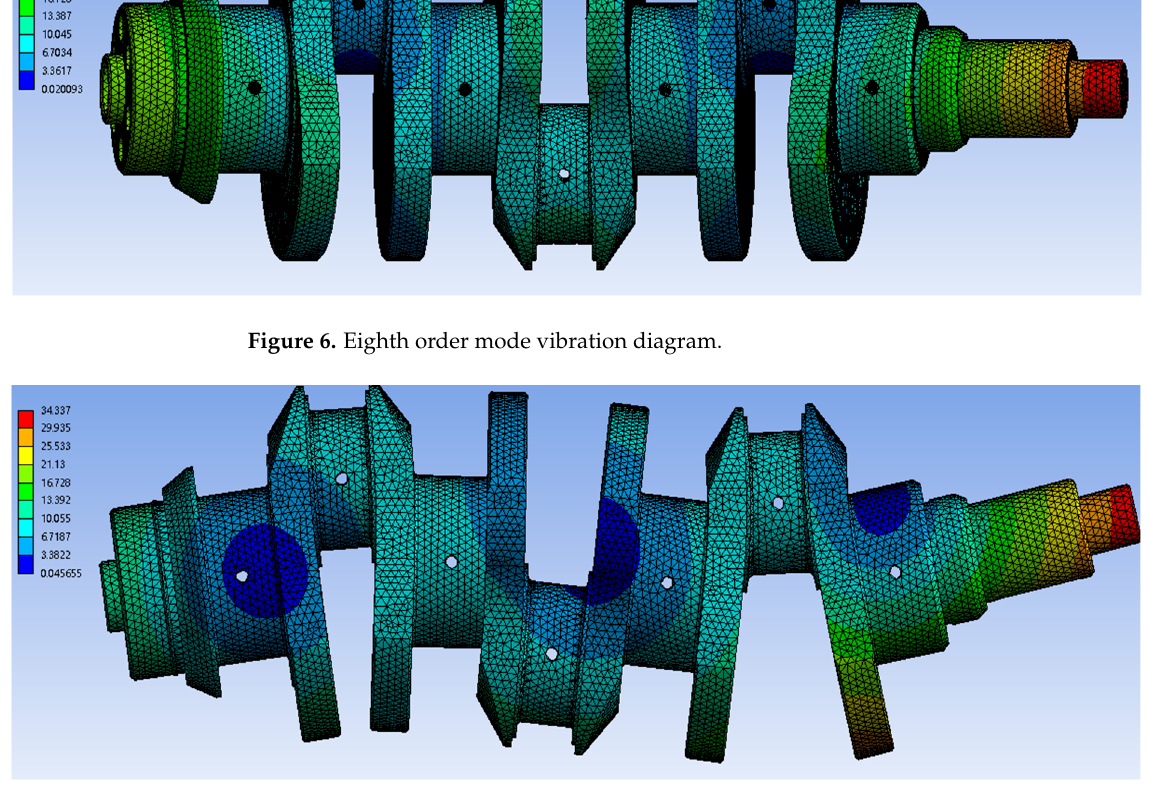
Figure 7. Ninth order modal vibration diagram.